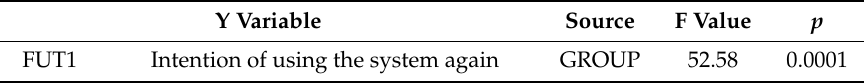
Table 6. Model with FUT1 “Intention of using the system again”.